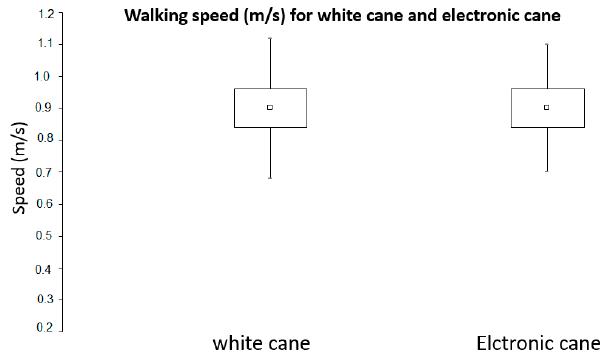
Figure 8. Effects of the simple white cane and Tom Pouce III on mean walking speed.